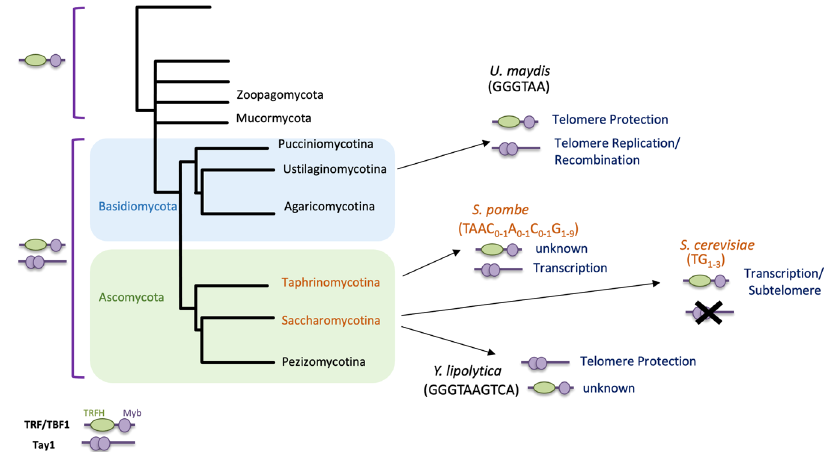
Fig. 7 Functional plasticity of the Tay1 protein family. A simpli fi ed fungal phylogeny is shown along with the distribution of the TRF/TBF1 and Tay1 protein family in the phylogeny. The tree is adapted from a previous study 51 . The phyla in which the telomere repeats deviate from the canonical GGGTTA sequence are indicated in red. The existence and functions of TRF/TBF1 and Tay1 homologs in selected organisms are also